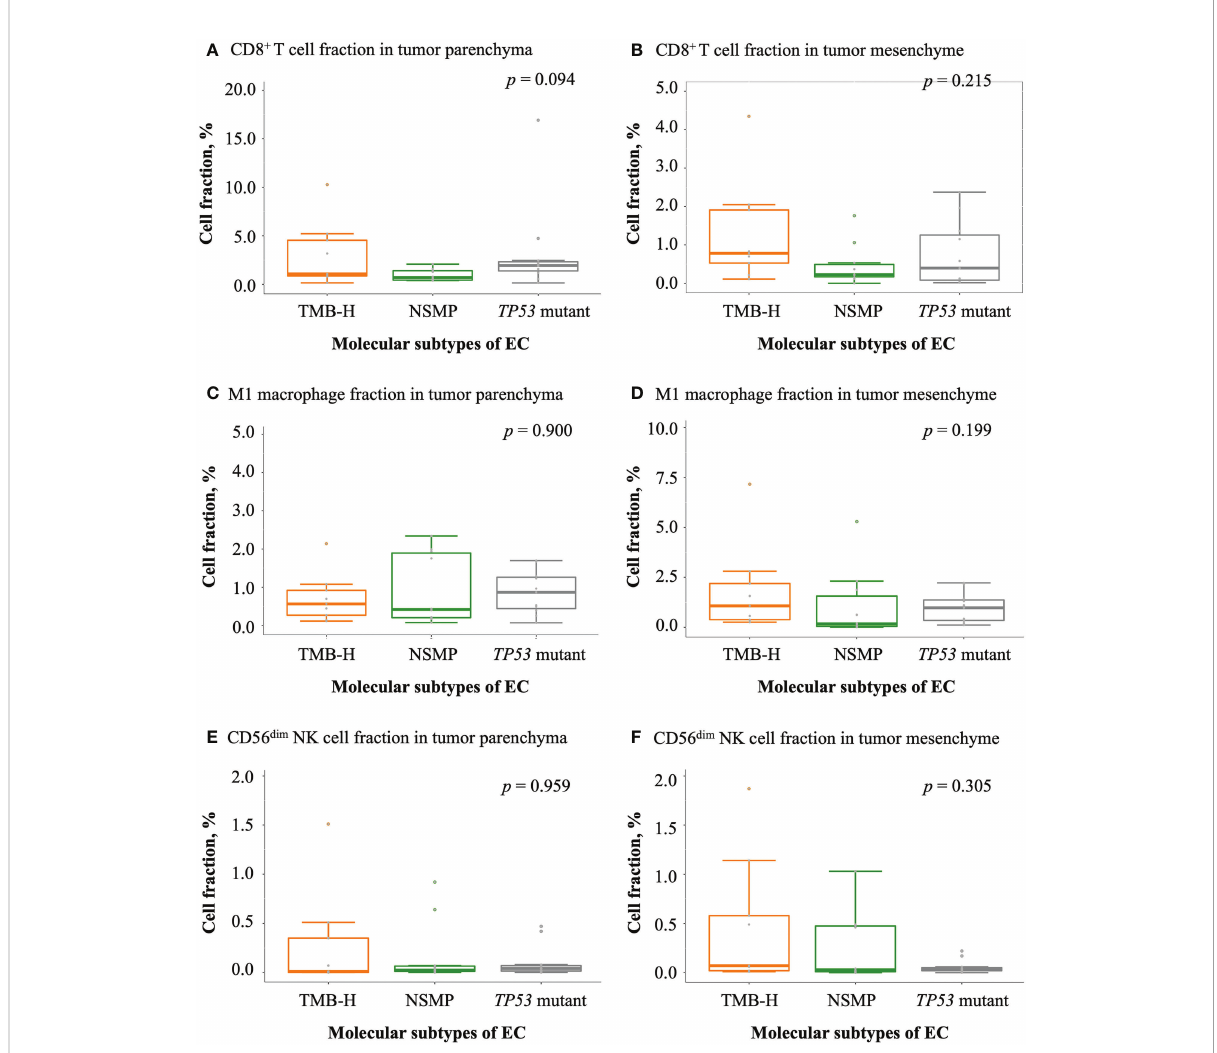
FIGURE 4 In fi ltration of antitumor-related immune cells in EC. (A, B) CD8 + T cell fractions in tumor parenchyma and mesenchyme. (C, D) M1 macrophage fractions in tumor parenchyma and mesenchyme. (E, F) CD56 dim NK cell fractions in tumor parenchyma and mesenchyme. For (A-F) , the p values of Kruskal-Wallis test for overall comparisons are given. In all panels, n = 9 for TMB-H, 10 for NSMP, 11 for TP53 mutant. The dots above the boxplots indicate outliers. TMB-H, high tumor mutation burden; NSMP, no speci fi c molecular pro fi le; EC, endometrial cancer; CD56 dim NK cell, CD56 dimly stained natural killer